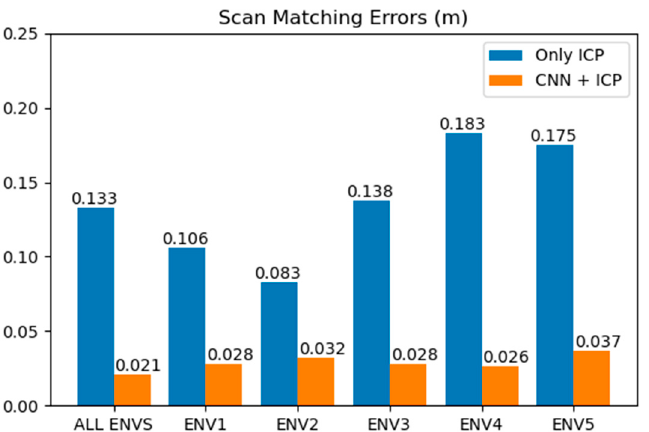
Figure 19. Comparison of methods in terms of scan matching error. The error is Euclidian distance of matched points, which represents the misalignment of scans.